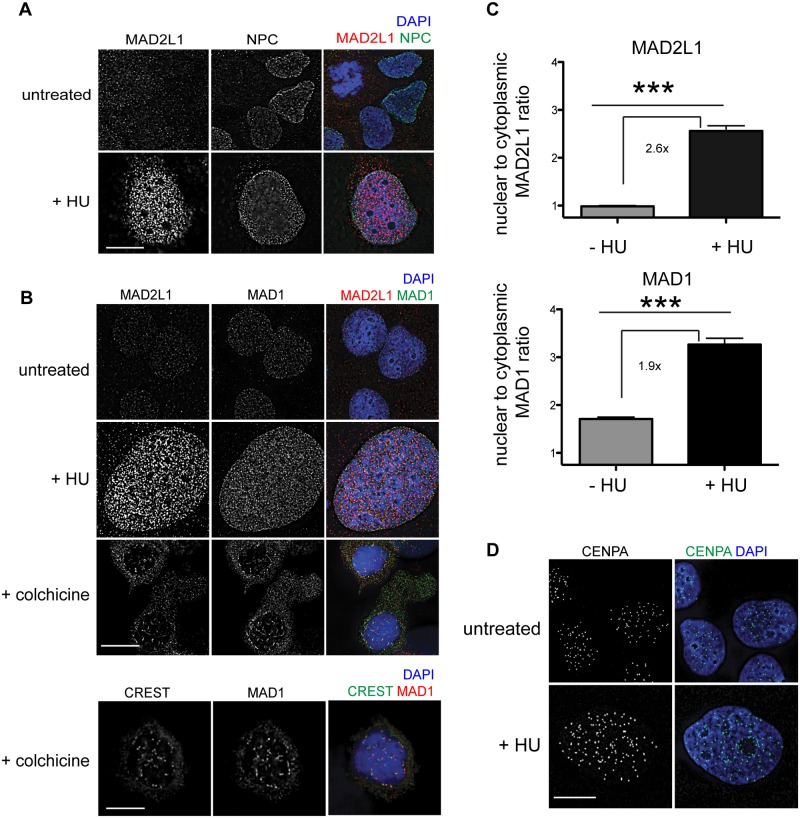
MAD1 and MAD2L1 are enriched in the nucleus in U2OS cells after HU exposure.(A) Untreated or HU treated U2OS cells stained with MAD2L1 (red) and Mab414 (NPC)(green) with DAPI (blue). (B) First panels show U2OS cells stained with MAD2L1 (red) or MAD1 (green) and counterstained with DAPI (blue) in untreated cells, with HU or with colchicine. Second panels show U2OS cells treated with colchicine and stained with CREST (green), MAD1 (red) and DAPI (blue). CREST recognizes CENP-A, -B, and—C. (C) Graph of the average ratio of nucleoplasmic MAD2L1 or MAD1 fluorescence to cytoplasmic signal in the presence and absence of HU; ***p<0.0001; n≥50; Error bars indicate SEM. (D) Untreated and HU treated U2OS cells stained with CENPA (green) and counterstained with DAPI (blue). Scale bars 10 μm.